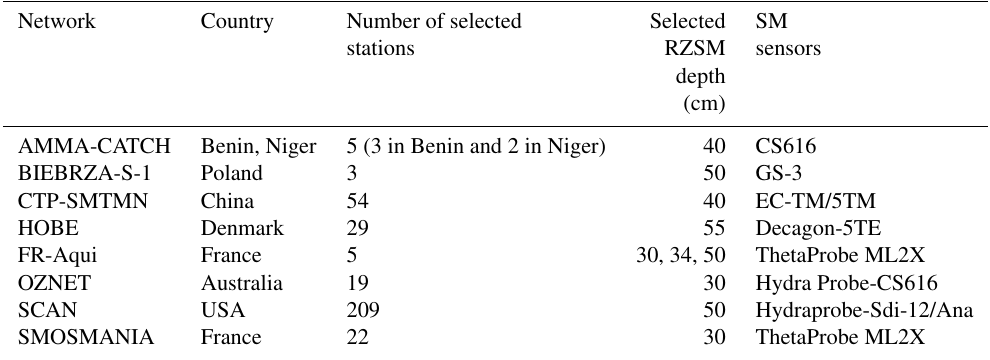
Table 2. Overview of the considered ISMN and external networks. Network Country Number of selected Selected SM stations RZSM sensors depth (cm) AMMA-CATCH Benin, Niger 5 (3 in Benin and 2 in Niger) 40 CS616 BIEBRZA-S-1 Poland 3 50 GS-3 CTP-SMTMN China 54 40 EC-TM/5TM HOBE Denmark 29 Decagon-5TE FR-Aqui France 30, 34, 50 OZNET Australia 19 Hydra Probe-CS616 SCAN USA 209 50 Hydraprobe-Sdi-12/Ana SMOSMANIA France 22 30 ThetaProbe